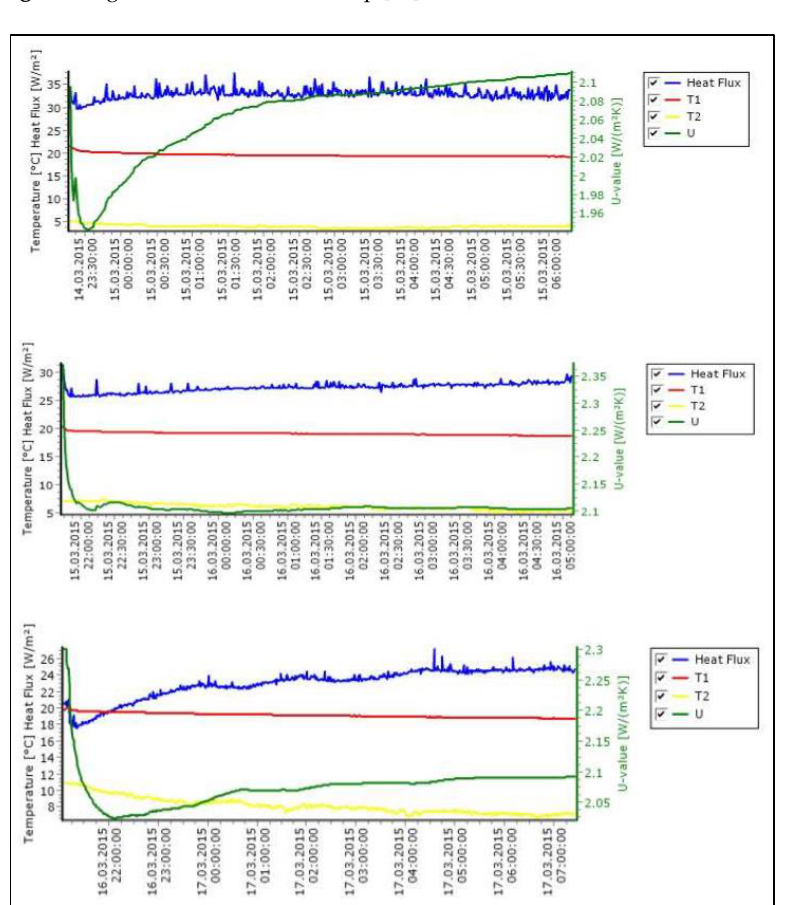
Figure 17. Results of Three Nighttime Measurements